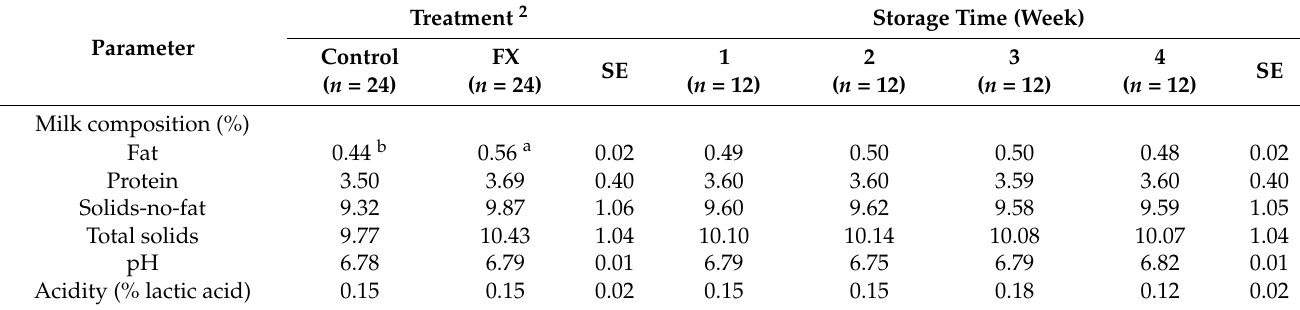
Table 6. Effect of fucoxanthin supplementation on goat skim milk composition, pH, and acidity 1 during storage (4 ◦ C). Treatment 2 Storage Time Parameter